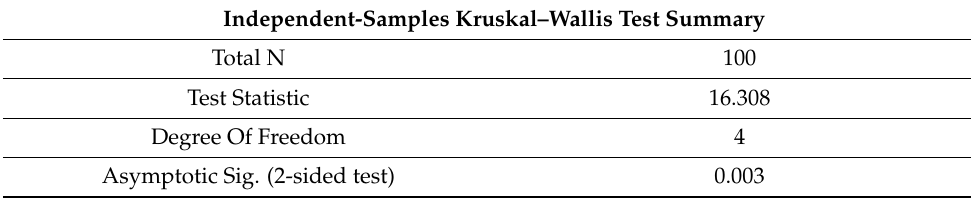
Table 5. Results of Kruskal–Wallis one-way ANOVA on ranks test for Sharpe ratio ranking.